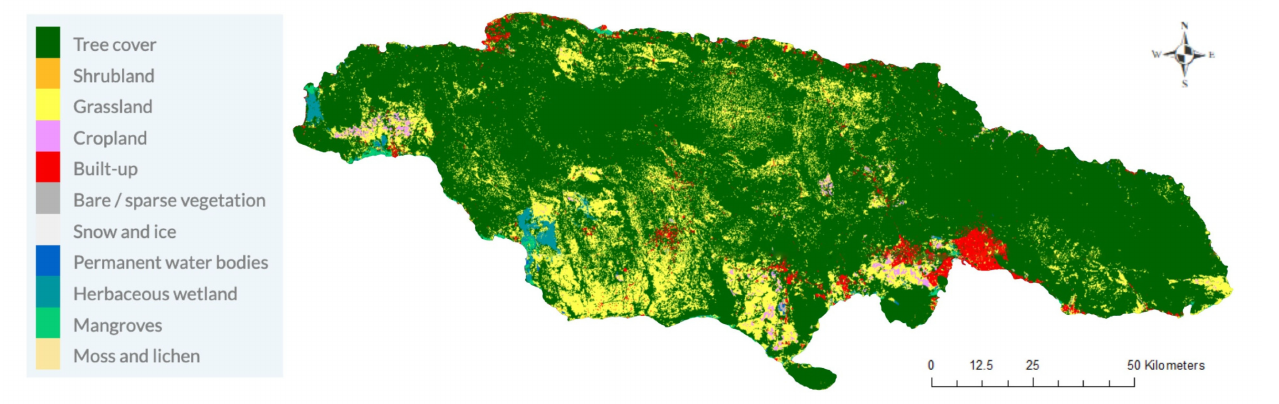
Figure 5. Jamaica’s land cover classes (ESA World Cover at: https://esa-worldcover.org/en (accessed on 31 October